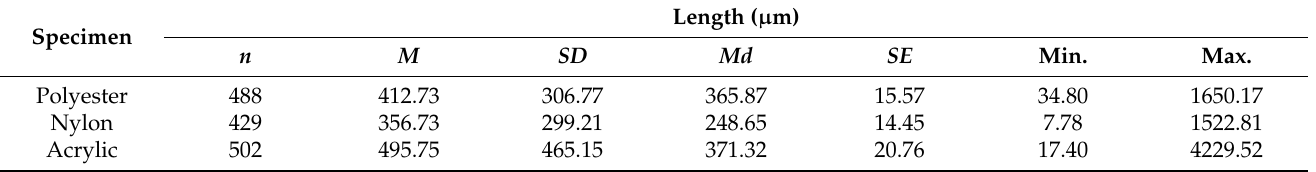
Figure 6. The length and number of microplastic fiber distribution. ( a ) The frequency distribution diagram of microplastic length for each fabric type. ( b ) The number of microplastic fibers of various lengths by fabric type. Table 3. Descriptive statistics of the fiber length of the released